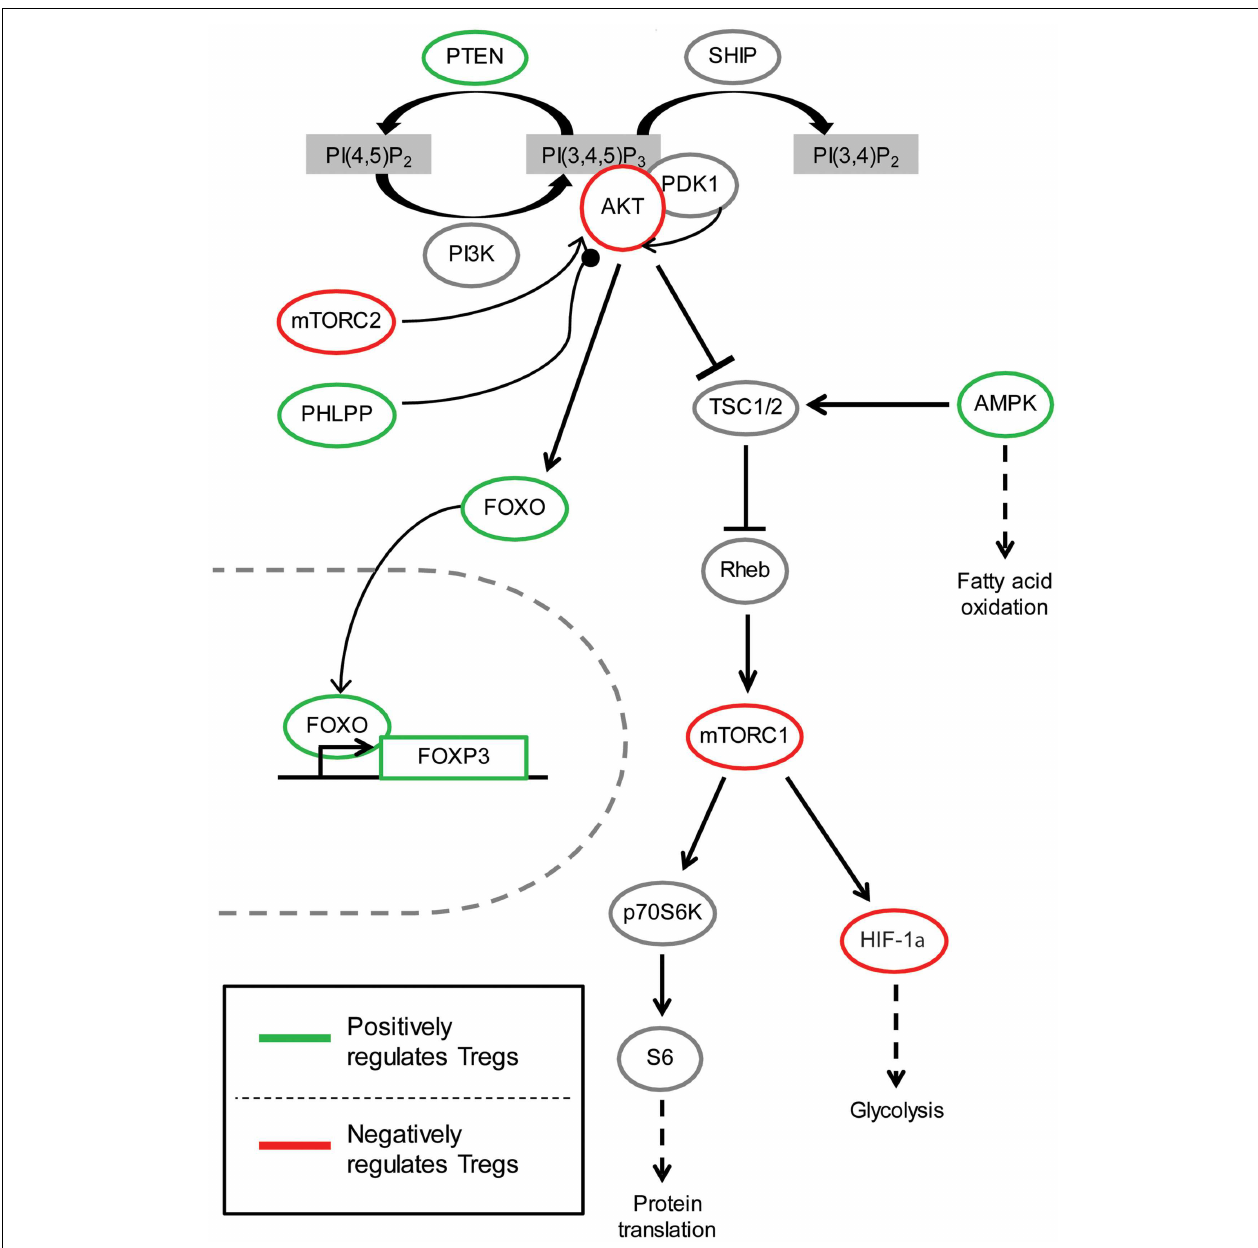
Green represents components of the PI3K/AKT pathway which have been shown to be beneficial forT reg function and/or development. On the contrary, red indicates molecules with activity thought to be inhibitory forT reg function and/or